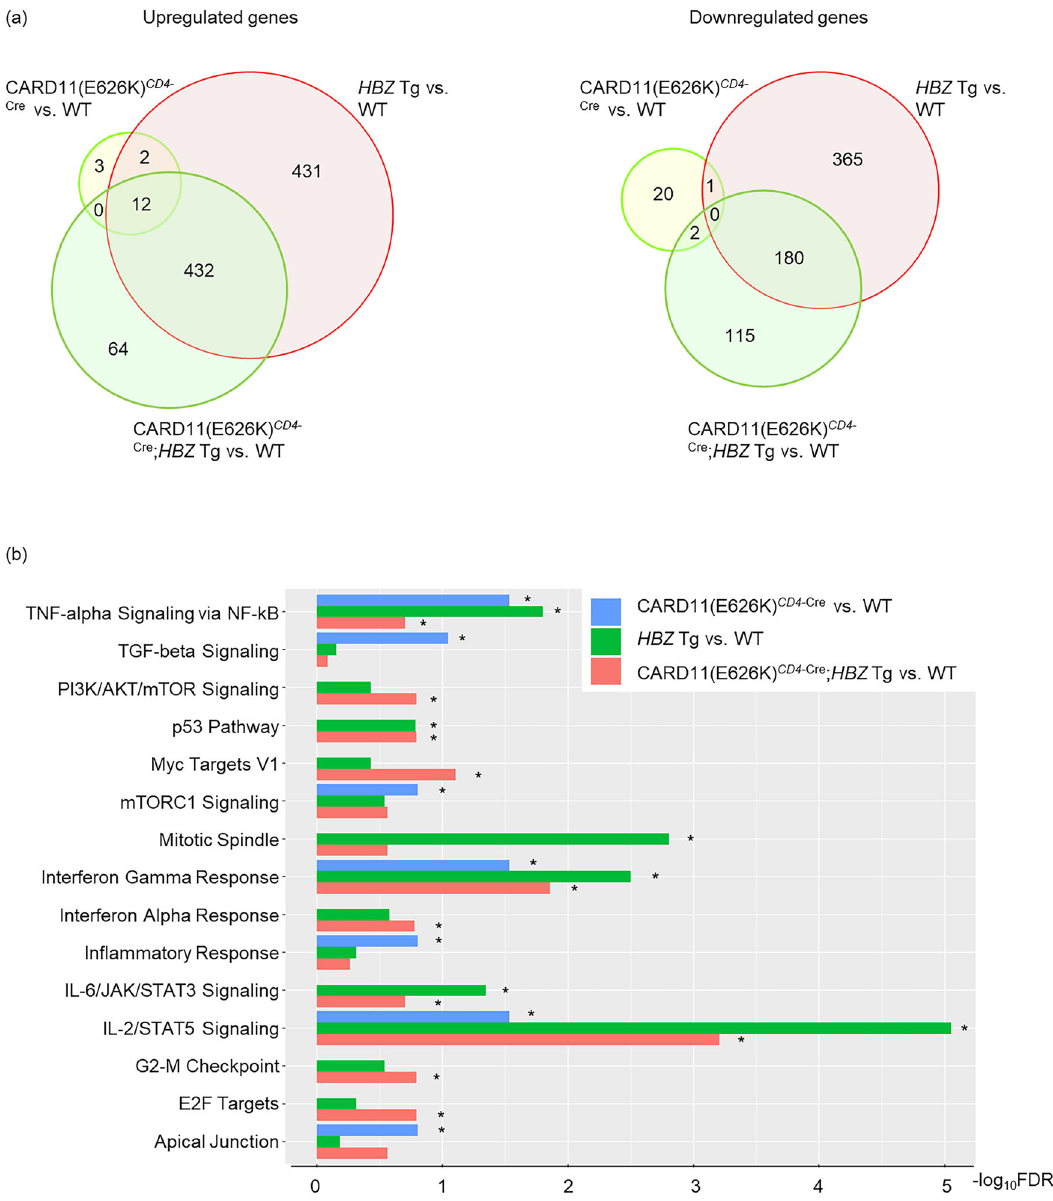
Fig. 6 Uniquely or commonly activated pathways in CARD11(E626K) CD4 -Cre , HBZ Tg, and CARD11(E626K) CD4 -Cre ; HBZ Tg mice. a Venn diagrams of the overlap between signi fi cantly up- and downregulated genes in CARD11(E626K) CD4 -Cre ( n = 3) vs. WT ( n = 3) mice, HBZ -Tg ( n = 4) vs. WT mice, and CARD11(E626K) CD4 -Cre ; HBZ Tg ( n = 3) vs. WT mice. Splenic effector/memory T cells (Tem) from 4 – 6-month-old mice were sorted and underwent expressional analysis. Differentially expressed genes between sample groups were identi fi ed, using cut-offs of fold change (FC) > 1.2 and an FDR of <0.1. b Bar plots of signi fi cantly (FDR < 0.25) upregulated KEGG pathways. Some pathways are uniquely activated in CARD11(E626K) CD4 -Cre mice, HBZ Tg mice, or CARD11(E626K) CD4 -Cre ; HBZ Tg mice. On the other hand, IL-2/STAT5 signaling and interferon-gamma response are commonly activated in all three types of